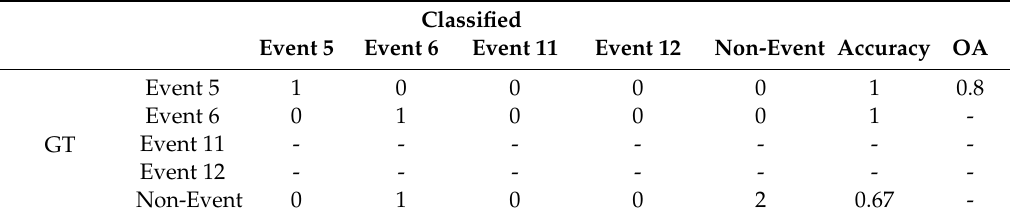
Event classification using the rule-based only approach for one VIRAT video: